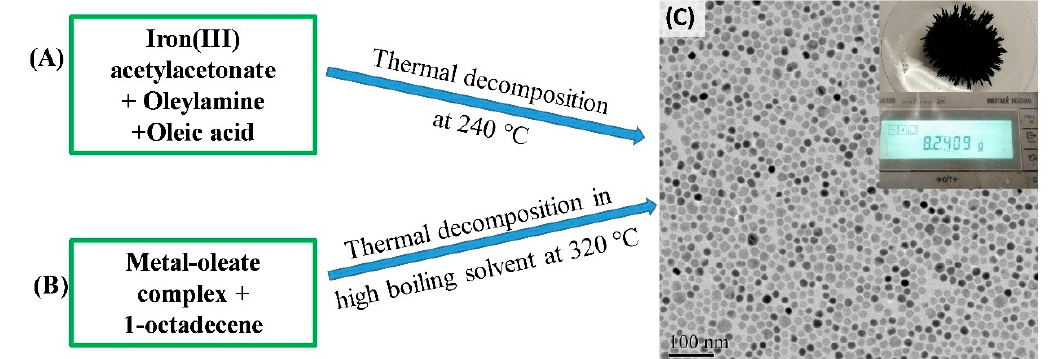
Figure 5. Schematic illustration of two simple approaches have been widely used to synthesize monodispersed iron oxide NPs: ( A ) Thermal decomposition of iron-precursor in oleylamine and oleic acid as surfactant and ( B ) thermal decomposition of metal-organic complex in octadecene. ( C ) Representative TEM image of 12 nm Fe 3 O 4 NPs prepared in large scale from the decomposition of iron (III) acetylacetonate. The inset is a digital photograph showing 8.2 g of the Fe 3 O 4 NPs produced in a single batch [71].